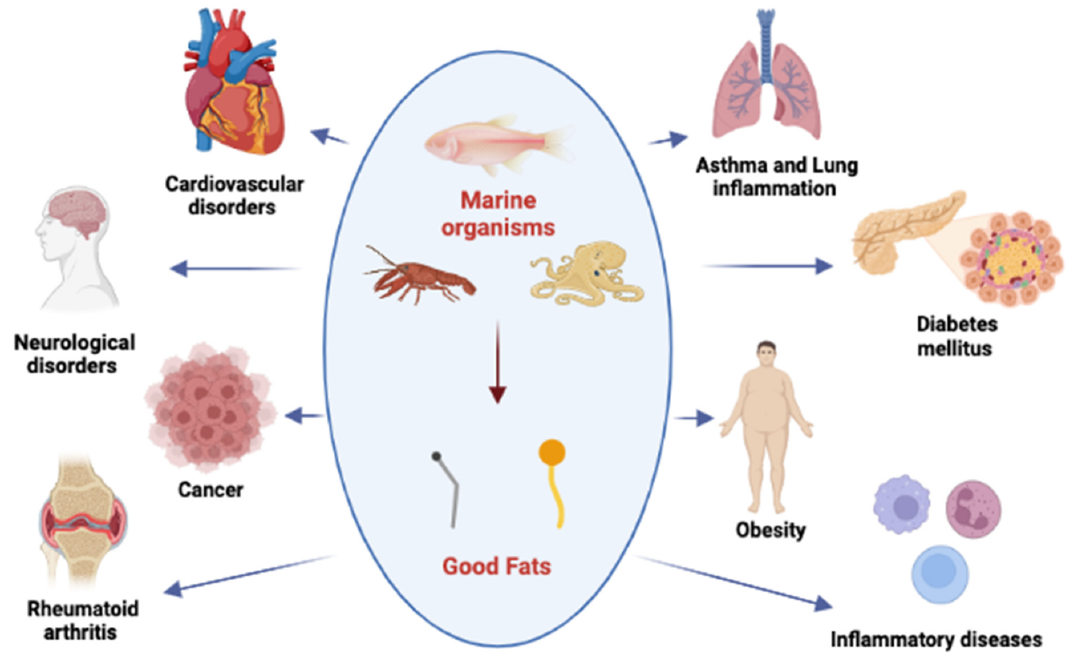
Figure 2 . The intake of “good fats” has many beneficial effects in the prevention and treatment of different chronic diseases. Created with BioRender.com. different chronic diseases. Created with